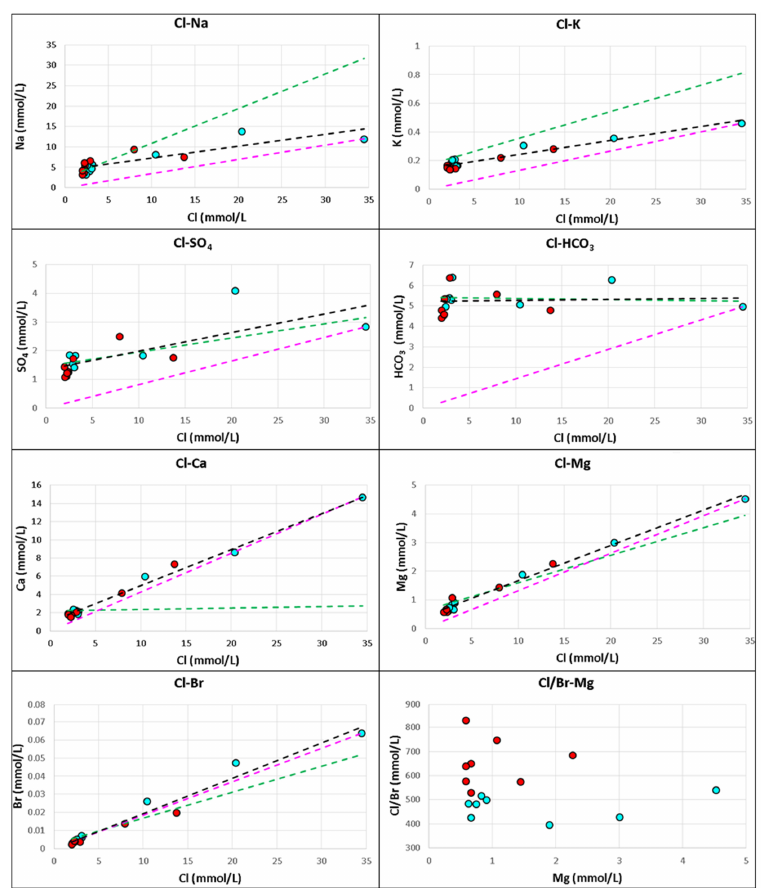
Figure 6. Cl concentration versus element concentration. The black line indicates the setting of the water samples. The green line represents the theoretical concentration by seawater, and the purple line is the theoretical dilution by rainwater infiltration.